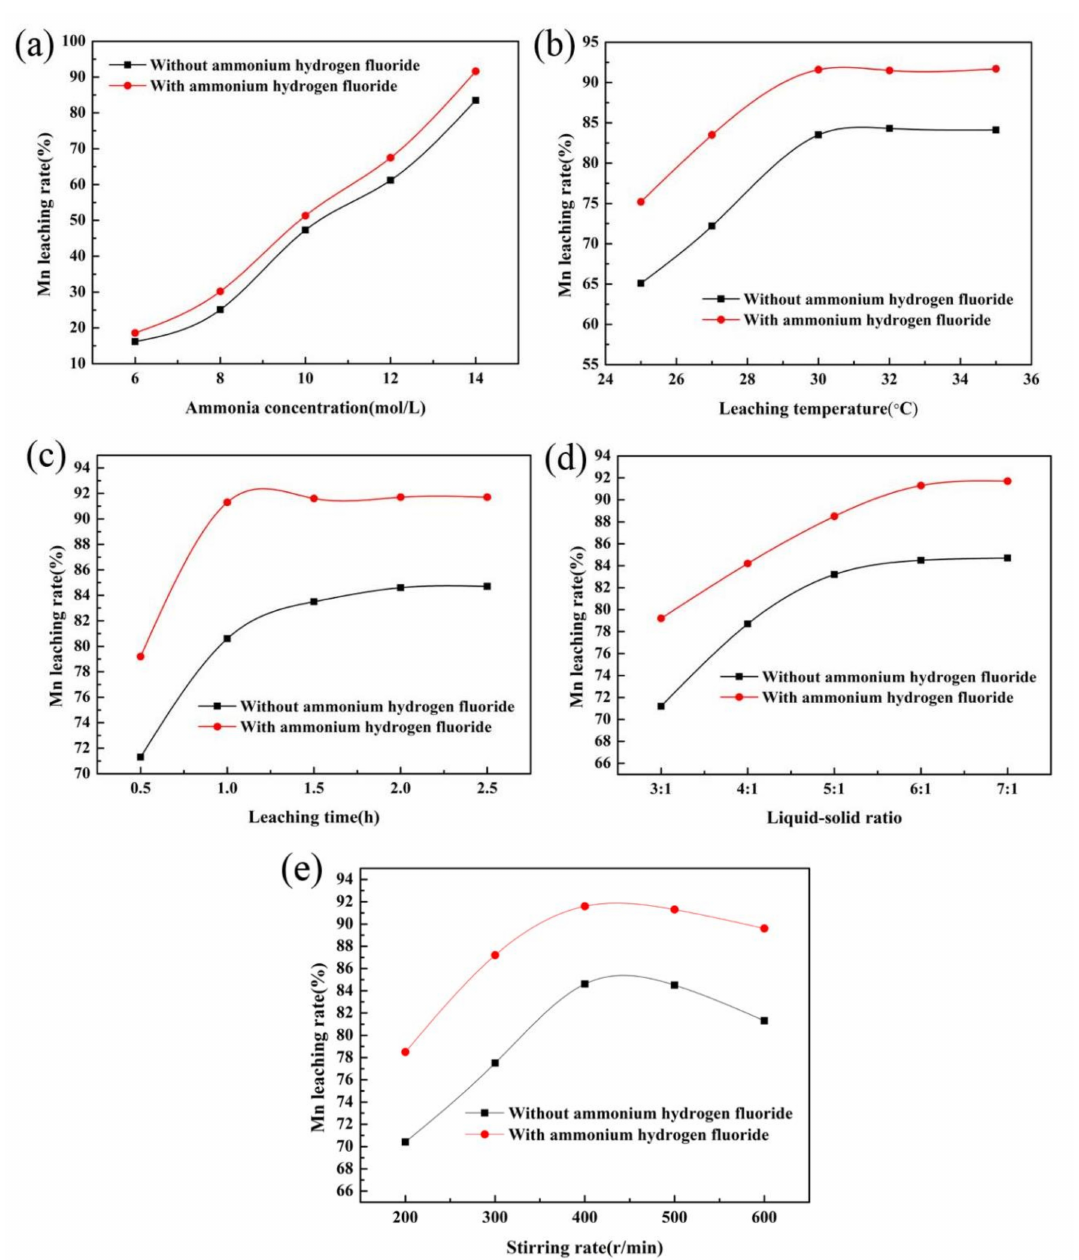
Figure 3. Effects of different factors on manganese leaching efficiency with or without annonium hydrogen fluoride. ( a ) Leaching temperature of 30 ◦ C, liquid–solid ratio of 6:1, stirring rate of 500 r/min, leaching 1.5 h, ammonium hydrogen fluoride dosage of 8% (and 0%); ( b ) ammonia concentration of 14 mol/L, liquid–solid ratio of 6:1, stirring rate of 500 r/min, leaching time of 1.5 h, amount of ammonium hydrogen fluoride of 8% (and 0%). ( c ) Leaching temperature of 30 ◦ C, ammonia concentration of 14 mol/L, liquid–solid ratio of 6:1, stirring rate of 500 r/min, ammonium hydrogen fluoride dosage of 8% (and 0%); ( d ) leaching temperature of 30 ◦ C, ammonia concentration of 14 mol/L, stirring rate of 500 r/min, leaching time of 1 h, amount of ammonium hydrogen fluoride of 8% (and 0%). ( e ) Leaching temperature of 30 ◦ C, ammonia concentration of 14 mol/L, liquid–solid ratio of 6:1, leaching time of 1 h, amount of ammonium hydrogen fluoride of 8% (and